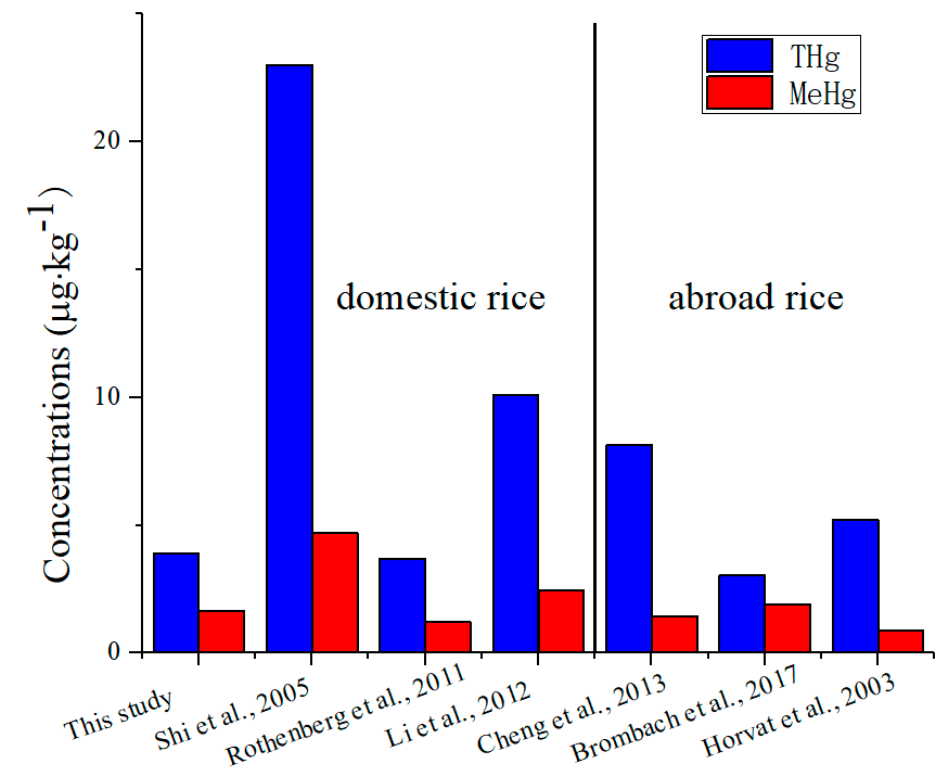
Figure 1. The THg and MeHg concentrations from rice in different study. Note: The samples collected by Horvat et al. were from Italy [13]; by Shi et al. from 15 provinces of China [15]; by Li et al. from 7 provinces in southern China [17]; by Cheng et al. from Cambodia [30]; by Brombach et al. from the Europe [31] and by Rothenberg et al. from Hubei province in China [32].